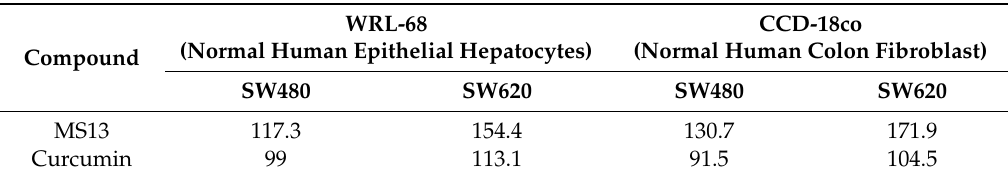
Table 2. Selective index (SX) values of MS13 and curcumin treated colon cancer (SW480 and SW620) and normal (WRL-68 and CCD18-co)